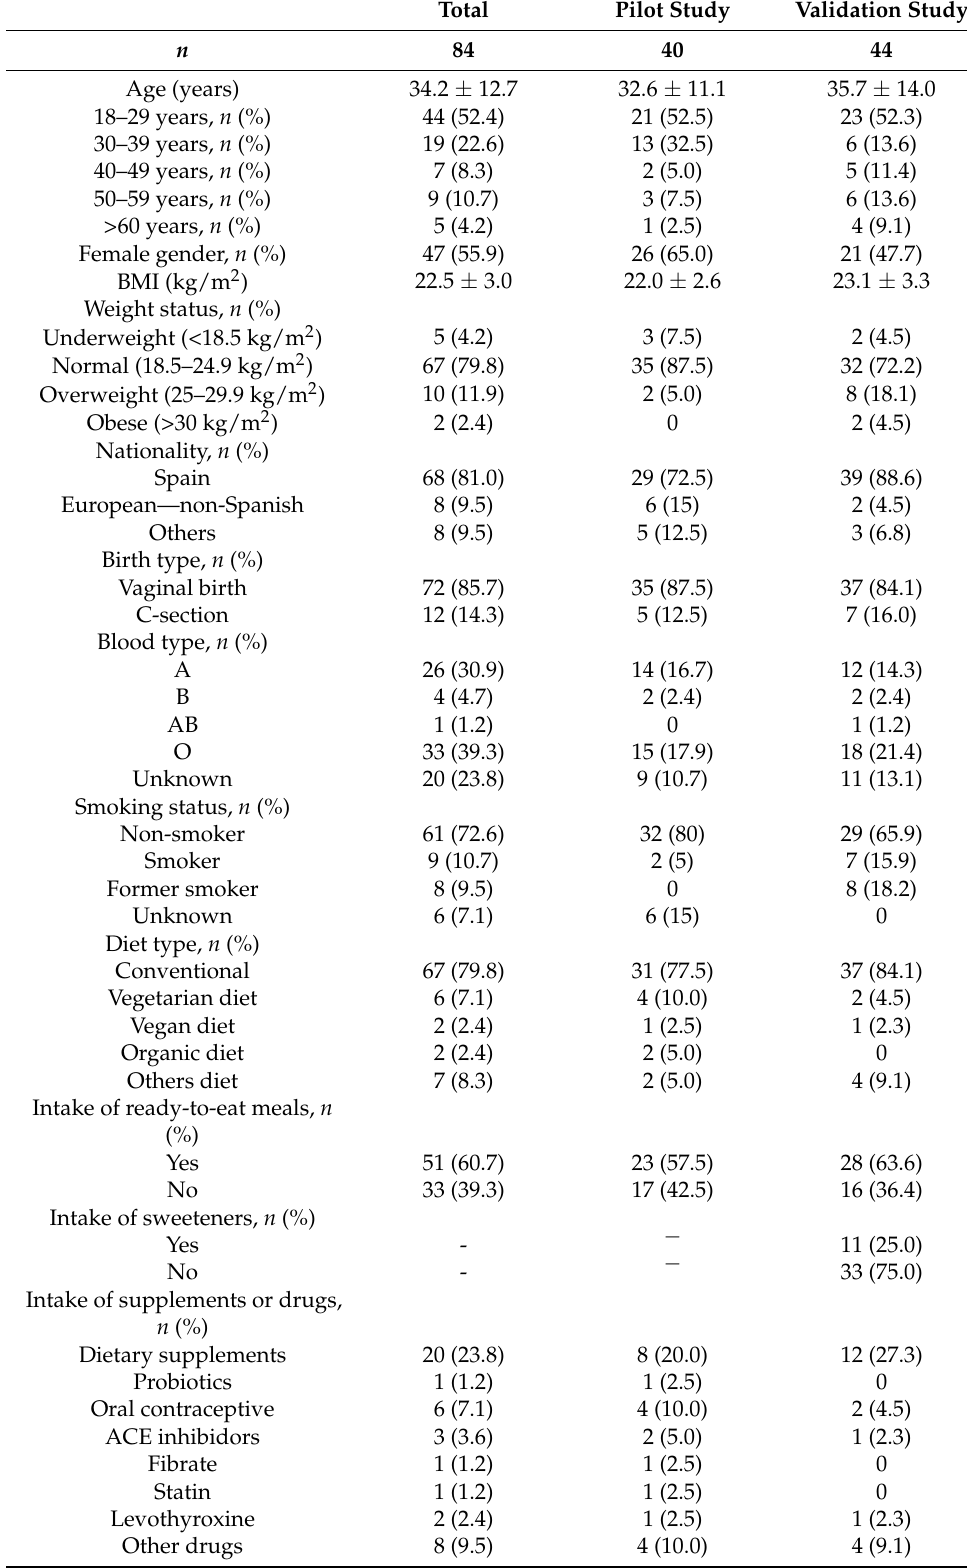
Table 1. Participants’